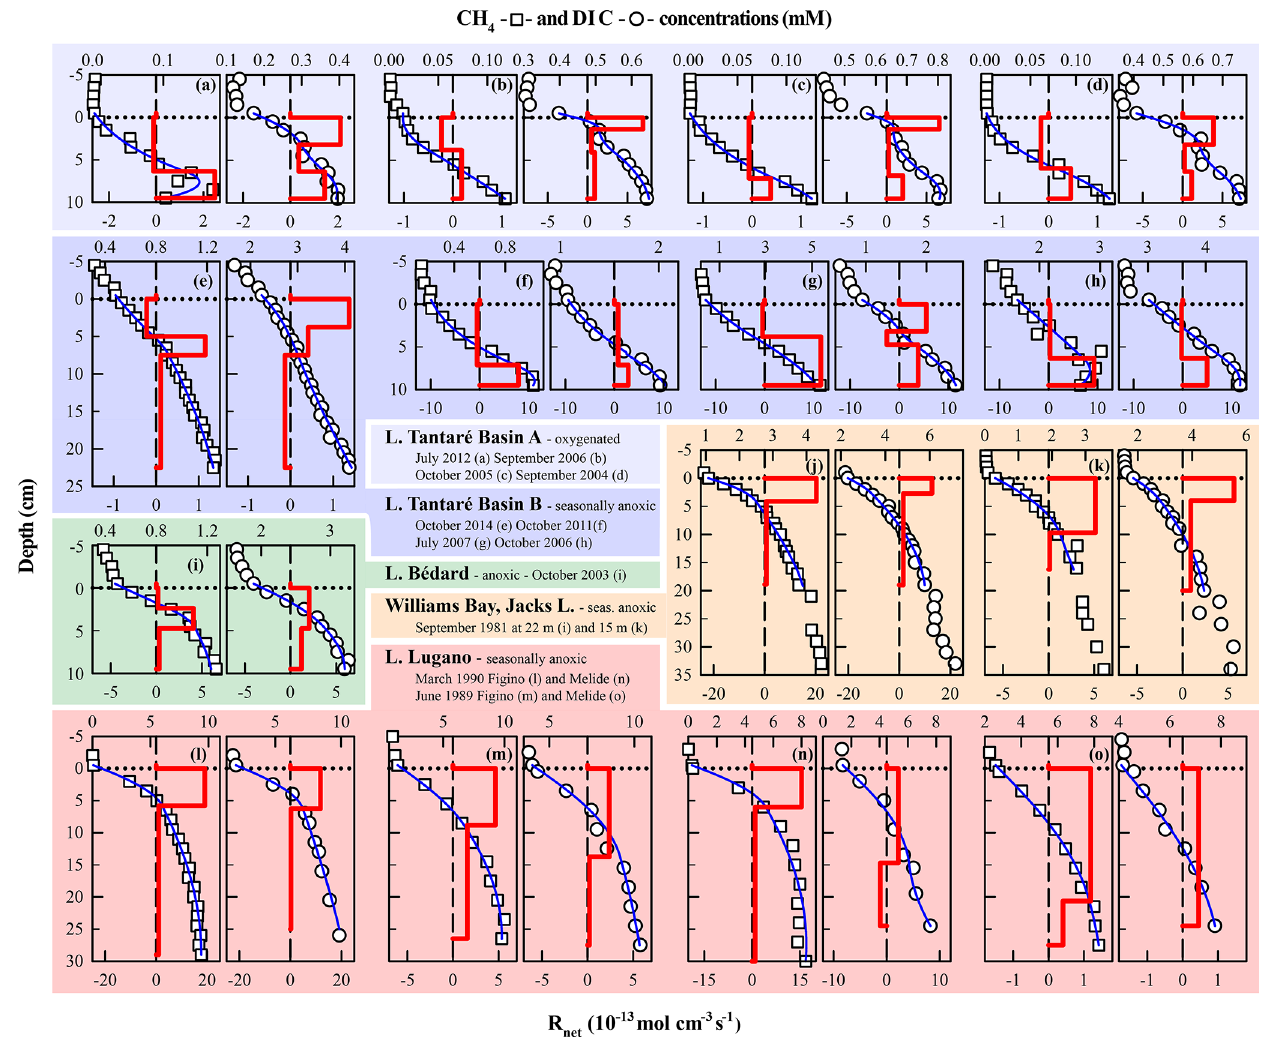
Figure 5. Comparison of the modelled (blue lines) and average ( n = 3) measured concentration profiles of CH 4 (squares) and DIC (circles) in Lake Tantaré Basin A (a–d) and Basin B (e–h) , Lake Bédard (i) , Jacks Lake (j–k) , and Lake Lugano (l–o) on various sampling dates. The thick red lines represent the net solute reaction rate ( R solute net